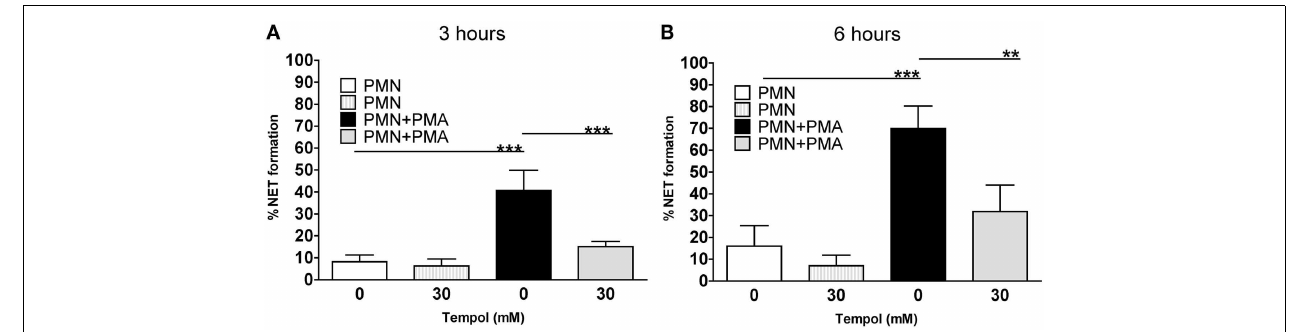
stimulated with PMA, gray bars:Tempol-treated PMNs stimulated with PMA. The percentage of cells undergoing NET formation was computed by using ImageJ as explained in materials and methods. Significance was analyzed by Tukey one-way ANOVA (** P ≤ 0.01 and *** P ≤ 0.001). Data are presented as means ± SD of three independent experiments with three different